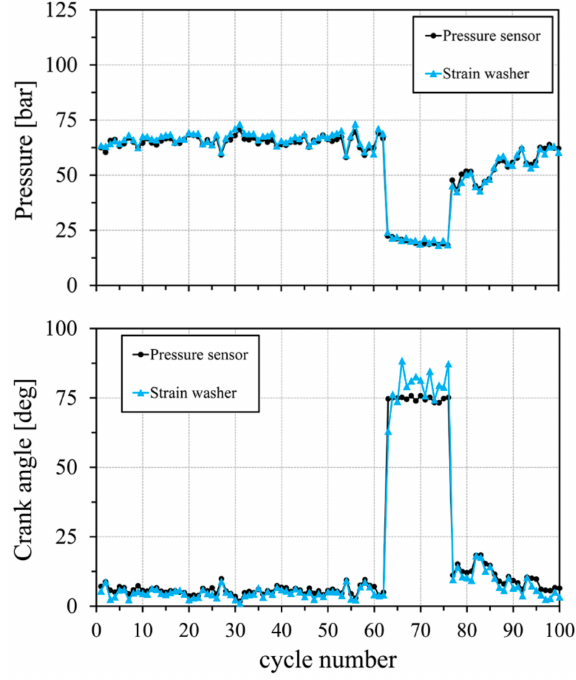
Figure 19. ( a ) Maximum in-cylinder pressure and ( b ) MBF50 evaluated by the strain washer and the pressure sensor in case of misfiring at 5000 rpm and full load on 100 consecutive